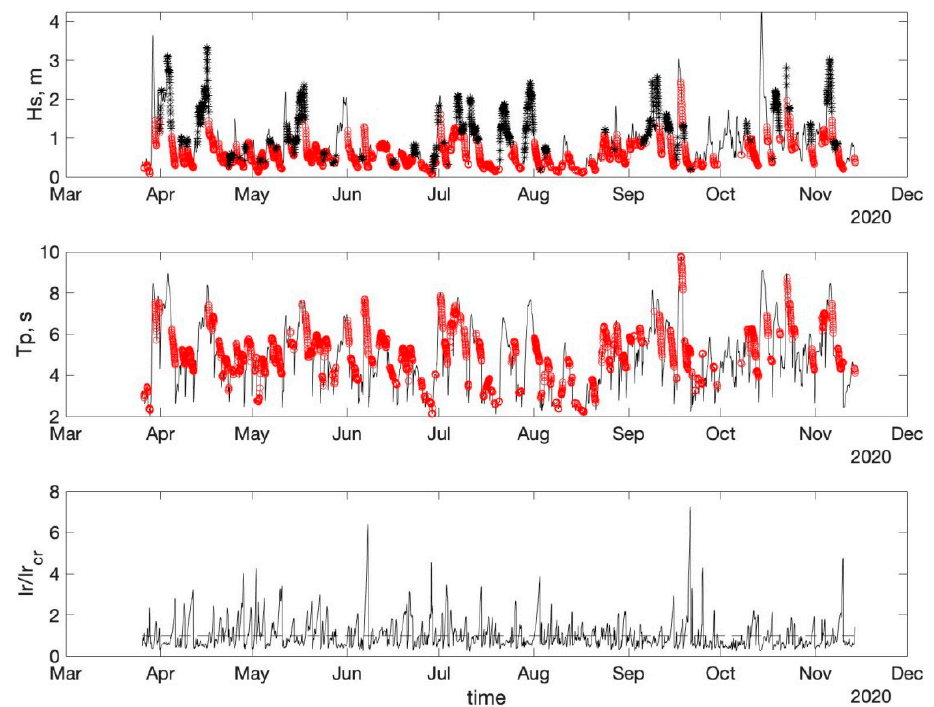
Figure 9. Wave height, peak wave period and ratio between deep water and critical Iribarren number (below the dashed line are regimes with pronounced exchange of energy between wave harmonics). Red circles—wave regimes without pronounced energy exchange between harmonics. Black stars—shore-normal